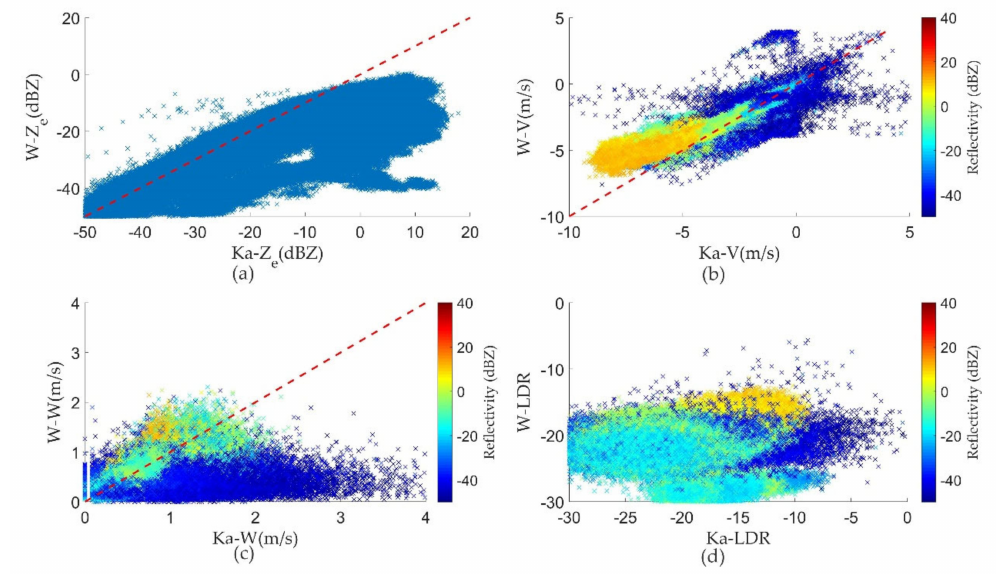
Figure 7. The measured ( a ) Z e , ( b ) V , ( c ) W and ( d ) LDR by the Ka-band radar vs. the W-band radar on 11 August 2019. The reflectivity from the Ka-band radar in ( b – d ) is also illustrated by colors. The red dotted line is the 1:1 line. Here, only the data that both the Ka-band radar and W-band radar have obtained are